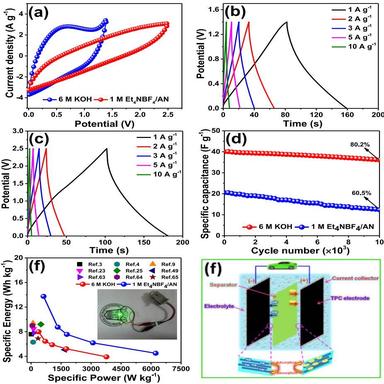
(a) CV curves of as-assembled SSCs in the appropriate potential windows at 50 mV s−1; GCD profiles of as-assembled symmetric devices (b) 6 M KOH electrolyte in a potential window of 1.4 V and (c) 1 M Et4NBF4/AN electrolyte in a potential window of 2.5 V at different current densities, (d) cycling stability of the as-assembled SSCs over 10,000 GCD cycles at 10 A g−1 and (e) comparison of Ragone plots of as-assembled SSCs with reported biomass carbons (insert: a LED powered with assembled SSC in 1 M Et4NBF4/A